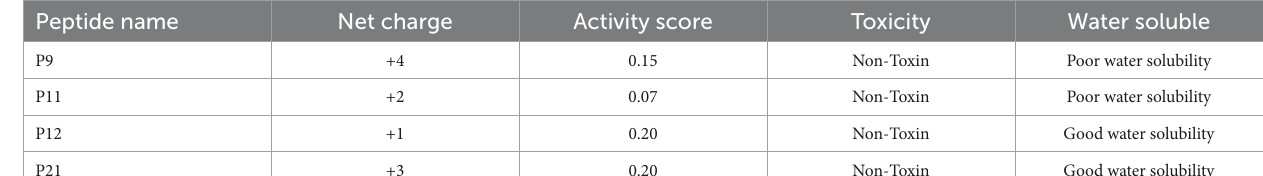
TABLE 2 Prediction of peptide biological activity, water solubility and toxicity.